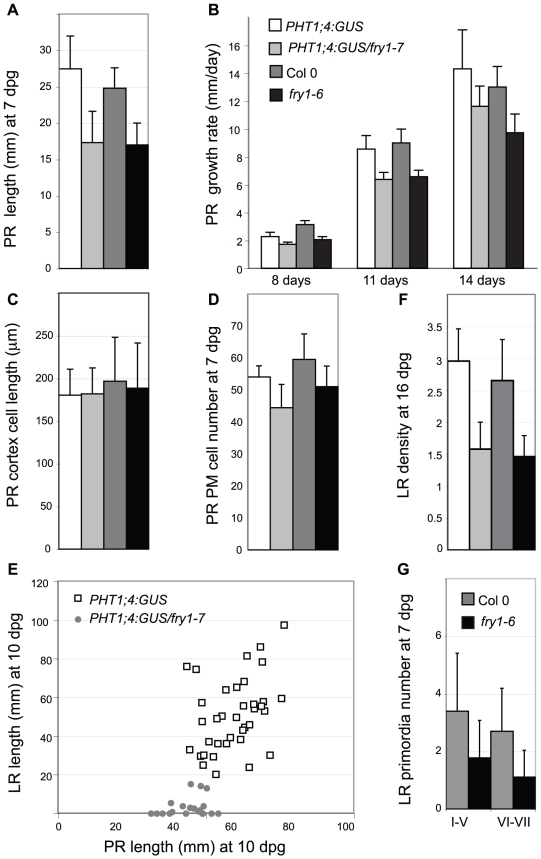
Root architecture of the fry1 mutants.(A) Primary root length at 7 days post germination (dpg). (B) Growth rate of the primary root at 8, 11 and 14 dpg on MS/10 medium. (C) Primary root cortical cell length. (D) Primary root proximal meristem (PM) cell number at 7 dpg. (E) Diagram plotting total lateral root length vs primary root length of the PHT1;4:GUS line (white squares) and PHT1;4:GUS/fry1-7 mutant (grey circles). 18 to 30 plants were measured per genotype, 10 dpg. (F) LR density of fry1 (number of LR per mm PR) at 16 dpg. (G) Number of LR primordia at early stages (I-V) and late stages (VI-VII), 7 dpg. The wild type and the mutant in A, B, D and G are significantly different (P<0.01) (Student's t-test). For A–D and F the white bars correspond to the PHT1;4:GUS parental line, the PHT1;4:GUS/fry1-7 mutant appears in pale grey, Col in dark grey and the fry1-6 mutant in black, as detailed in panel B. For all the analyses, at least three independent experiments gave similar results. Standard deviations are shown.